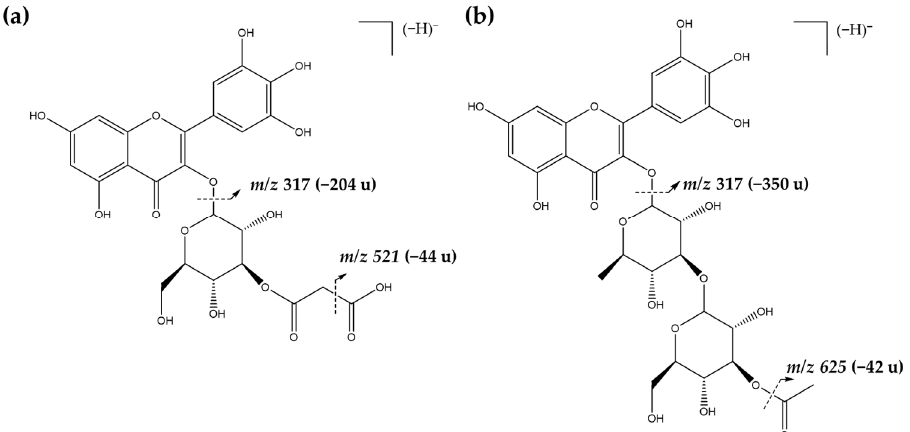
Figure 2. Chromatographic profile at 280 nm for BP6 phenolic extract.